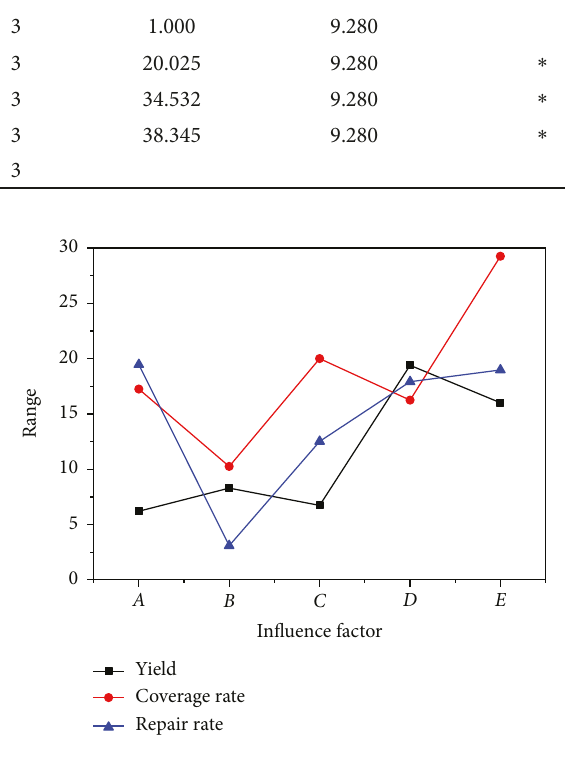
Figure 4: Range of e ff ects of factors on yield, coverage rate, and repair rate.